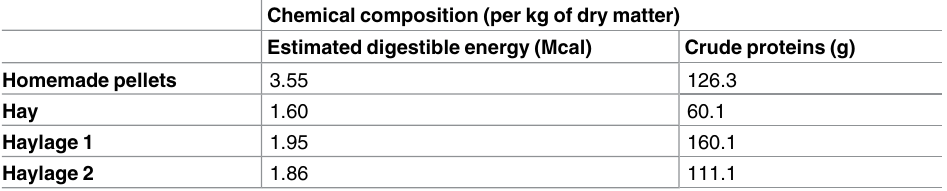
Table 3. Quality of feedstuff from NRC [32] given to yearlings during feeding challenge (19 to 24